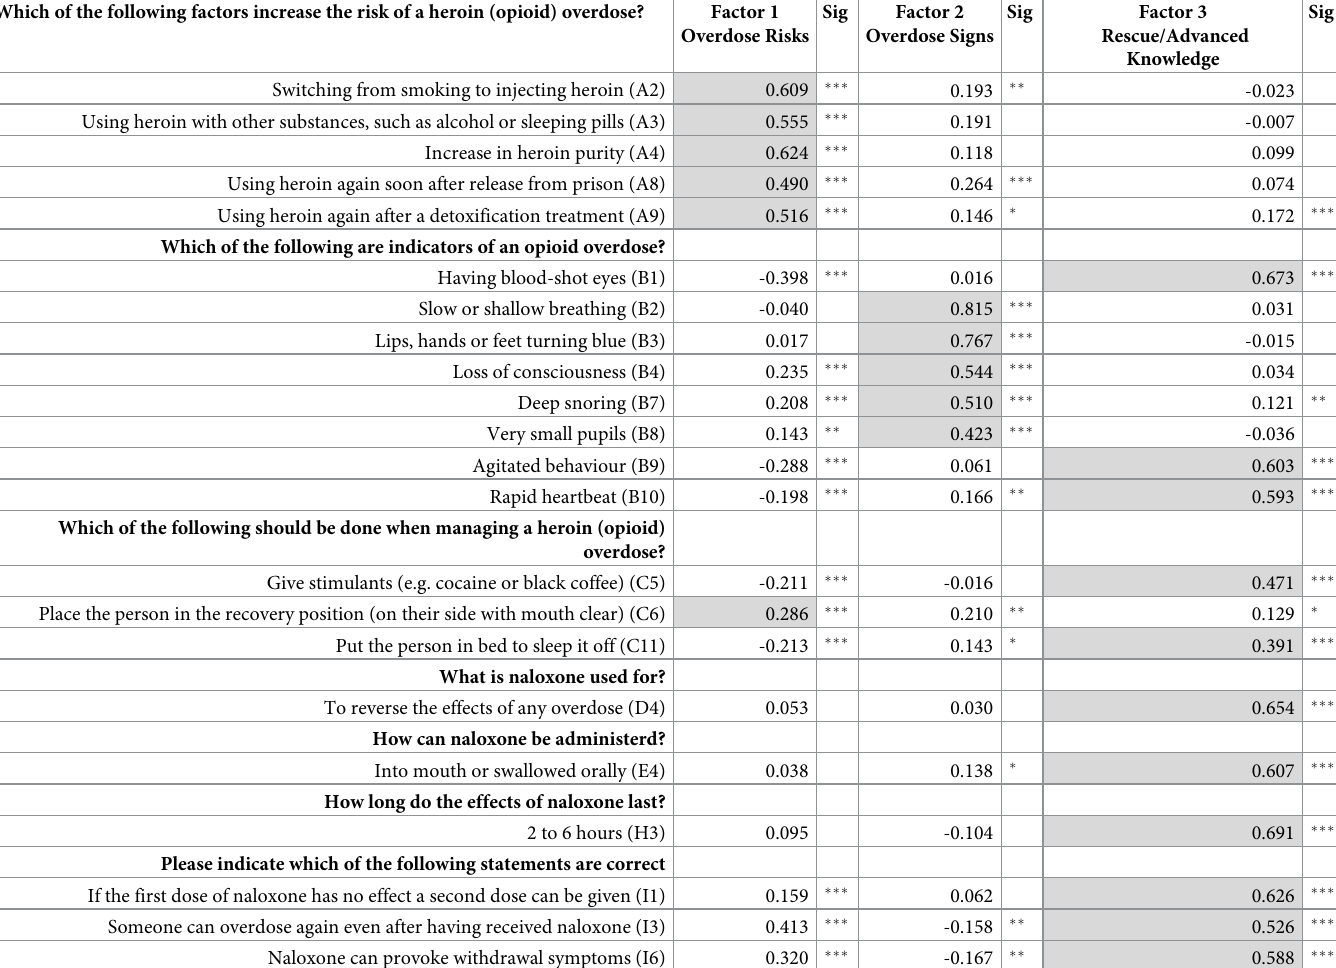
Table 2. ESEM three-factor model structure for selected OOKS pre-test items. Which of the following factors increase the risk of a heroin (opioid)